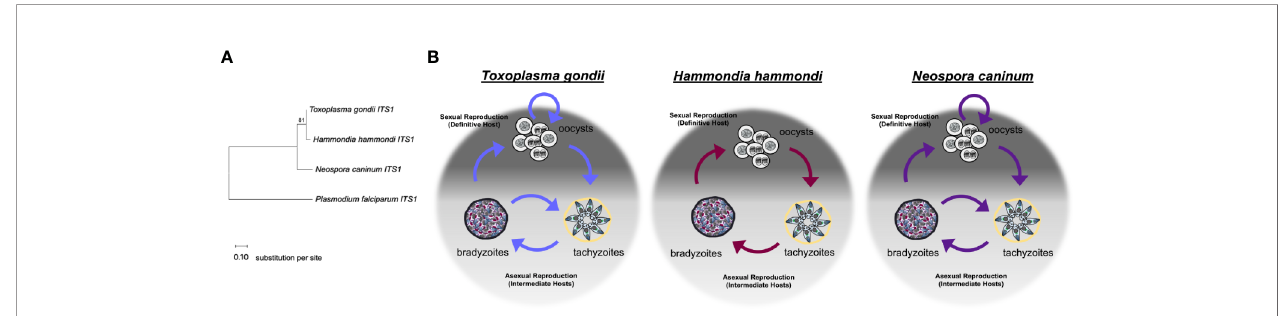
FIGURE 1 | Relationships between Toxoplasma gondii , Hammondia hammondi , and Neospora caninum. (A) Neighbor-joining tree depicting relationship between the ITS1 (internal transcribed spacer 1) sequences of T. gondii , H. hammondi , and N. caninum . P. falciparum is used as an outgroup. ITS1 sequences were chosen to highlight the relationship between these parasite species due to high variability often attributed to these non-coding sequences. Sequences were obtained from GenBank. Bootstrap values for 1000 replicates are indicted. Scale bar represents the substitutions per site. (B) Diagrams showing the life cycle of T. gondii , H. hammondi , and N.